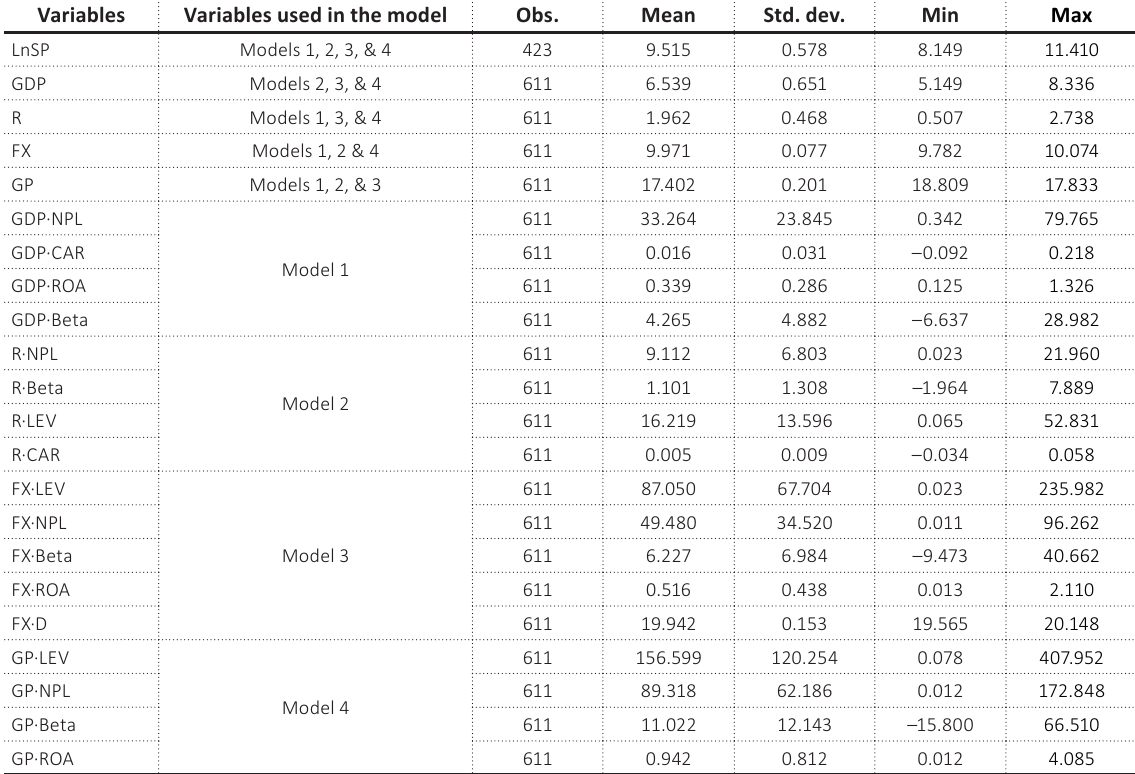
Table 2. Descriptive statistics for variables used in the